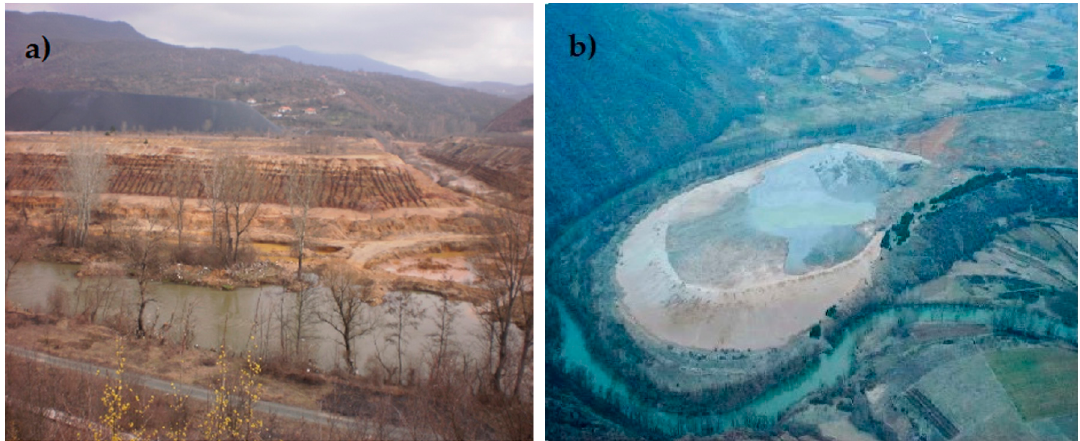
Figure 2. Tailing pond Gornje Polje ( a )—not active; and tailing pond Bostanište ( b